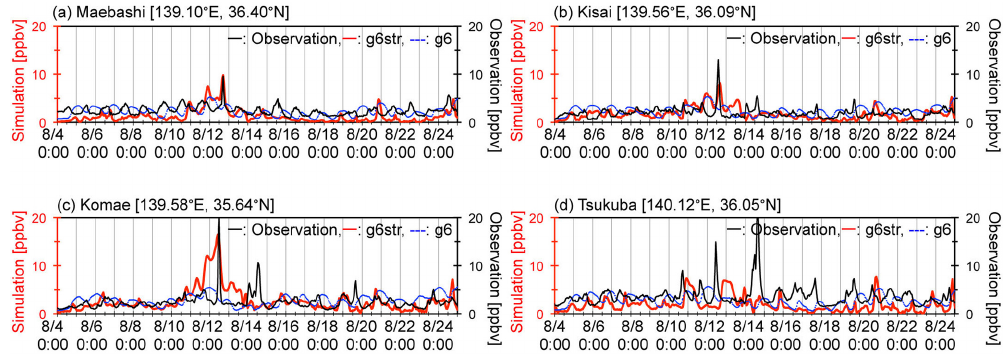
Figure 13. Same as Fig. 12 but for SO 2 without the WRF-CMAQ results, in units of ppbv.